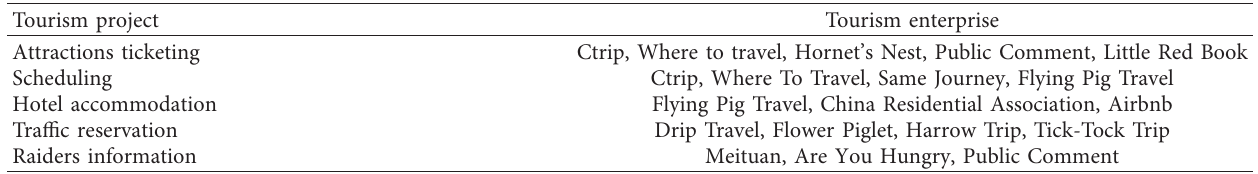
Figure 6: Utilization rate of tourism platform. Table 2: Application of main functions of tourism